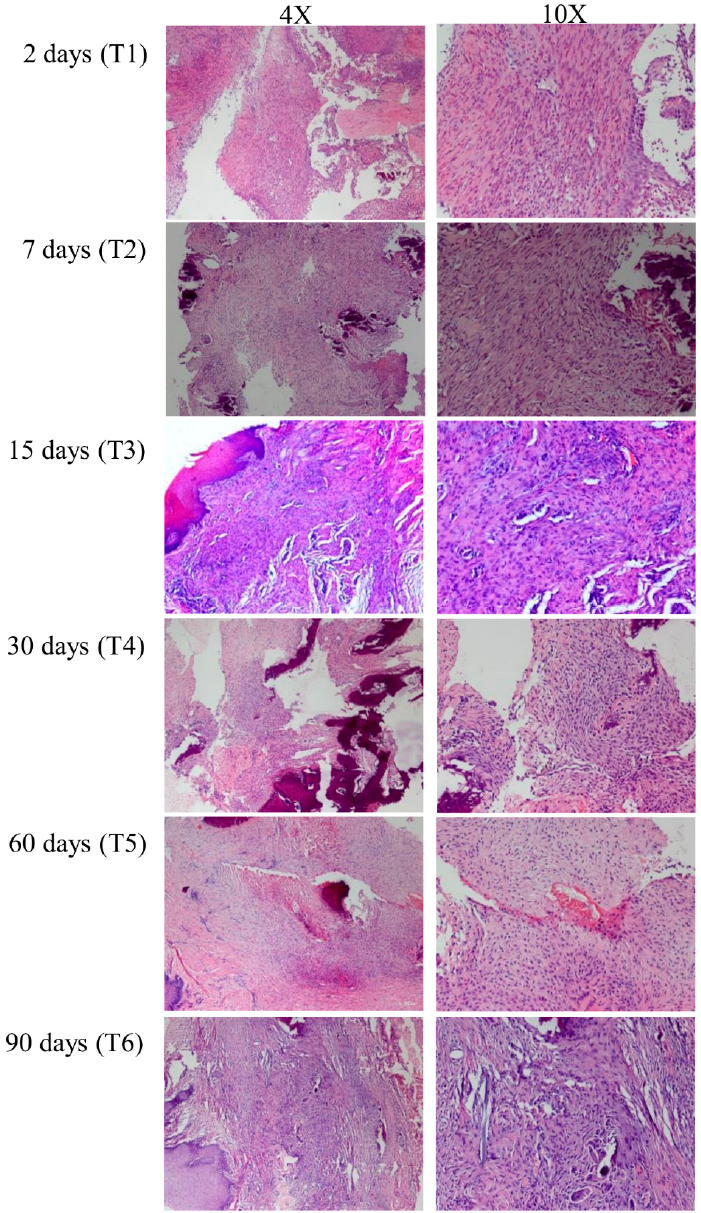
Figure 1. Hematoxylin and eosin stained histological sections of representative sockets at 2 (T1), 7 (T2), 15 (T3), 30 (T4), 60 (T5), and 90 (T6) days post ‐ extraction. For each group, 4 × and 10 × 15 (T3), 30 (T4), 60 (T5), and 90 (T6) days post-extraction. For each group, 4 × and 10 × magnifications magnifications are reported. are